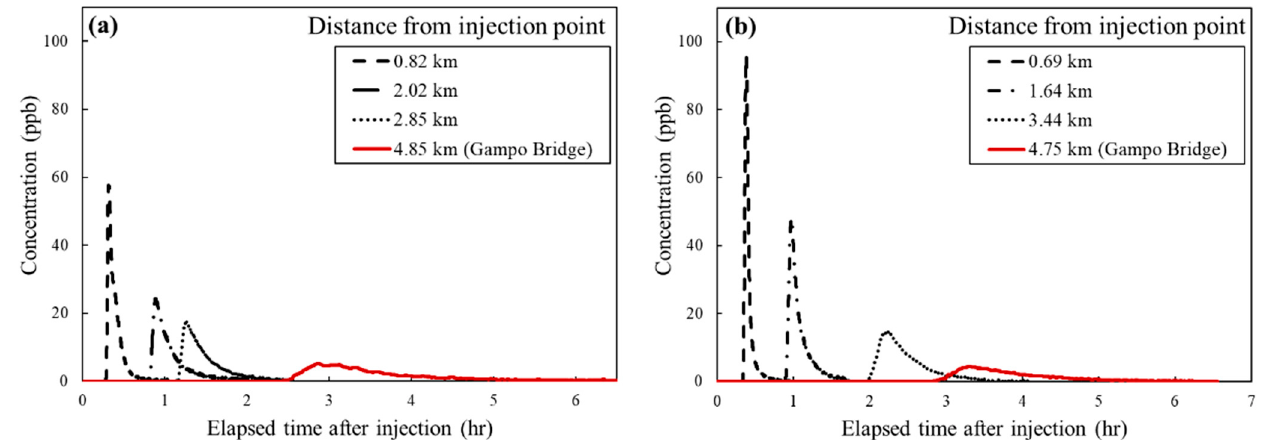
Figure 5. BTCs of ( a ) Test 1 and ( b ) Test 2 at different distances downstream of the injection point.